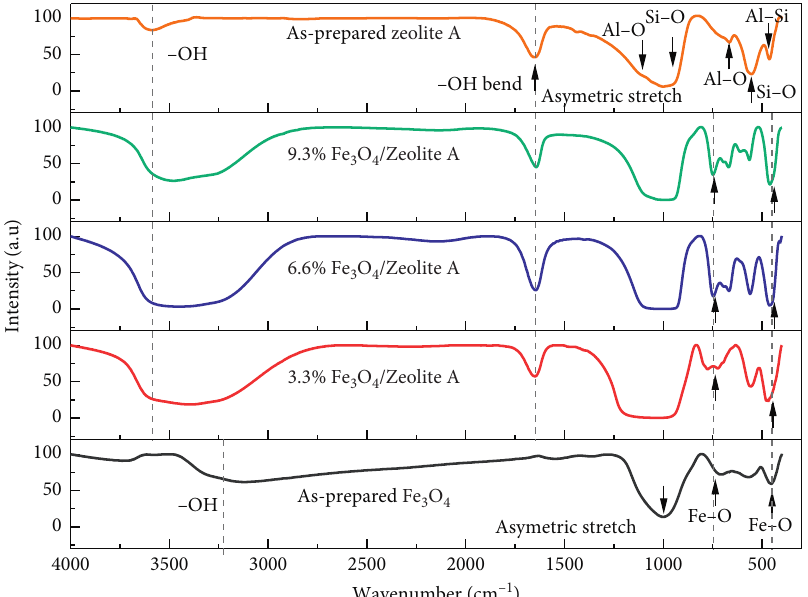
Figure 6: FTIR spectra of zeolite A Fe 3 O 4 NPs and Fe 3 O 4 /ZA nanocomposite samples with different Fe 3 O 4 NP loadings (wt.